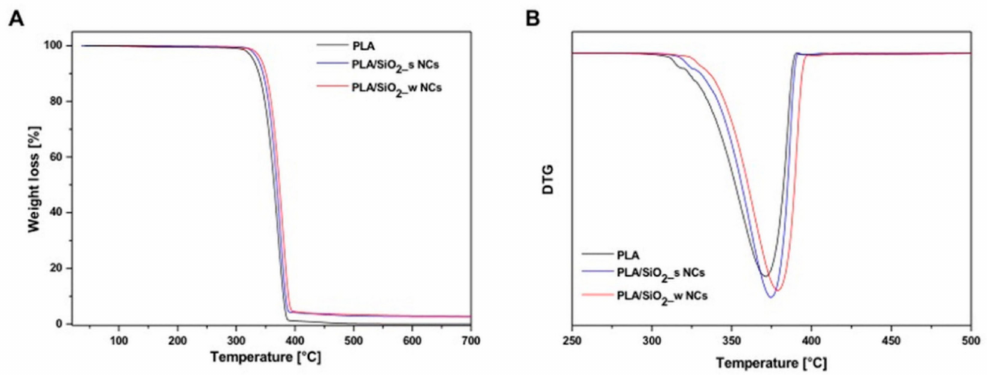
Figure 5. Thermogravimetric ( A ) and Derivative Thermogravimetric ( B ) curves of pure PLA and PLA / SiO 2_ s and PLA / SiO 2_ w